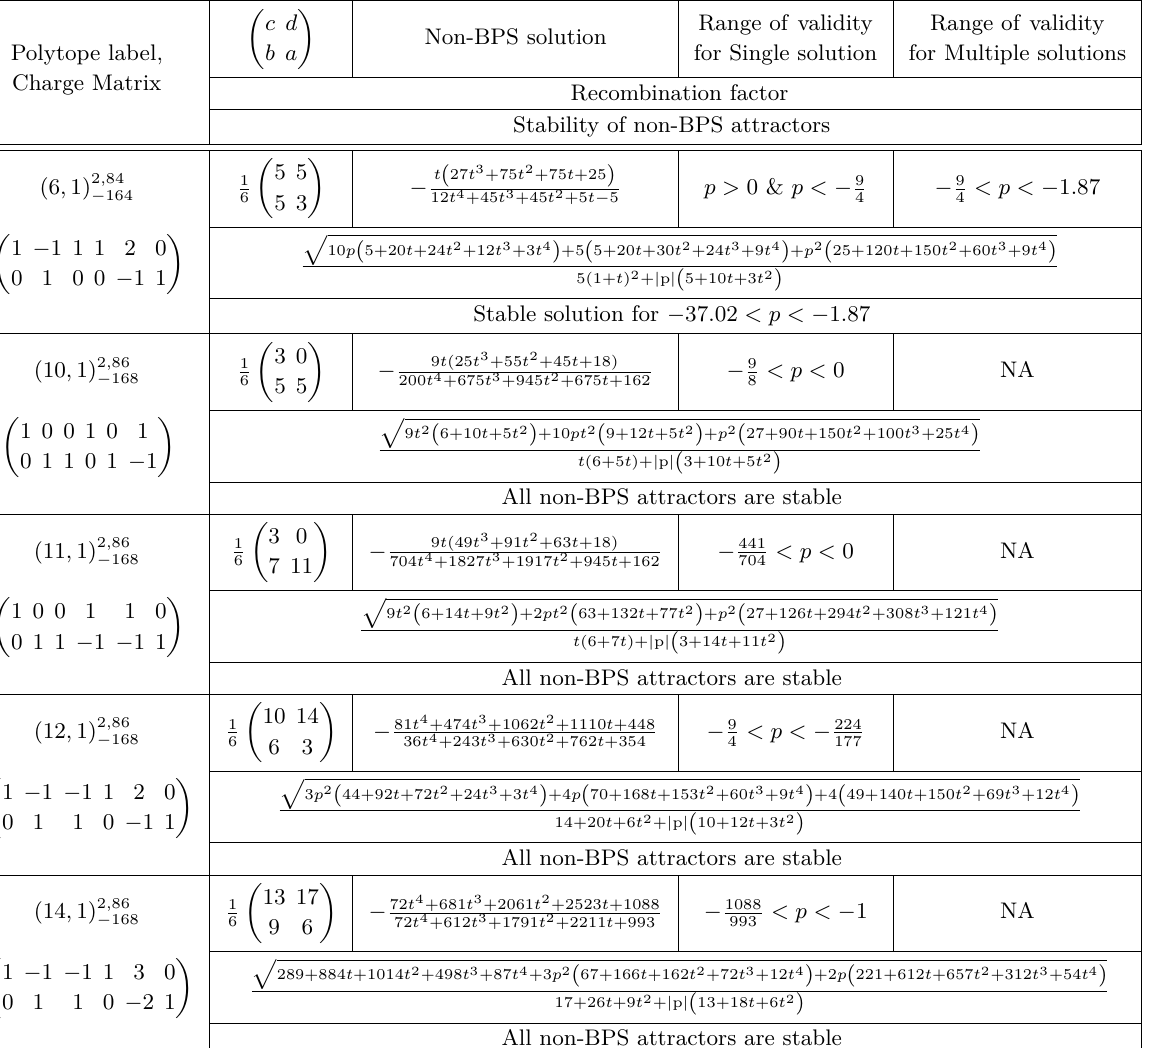
Table 13 . Non-BPS extremal (multiple) black strings in one-modulus THCY models, 2/8.